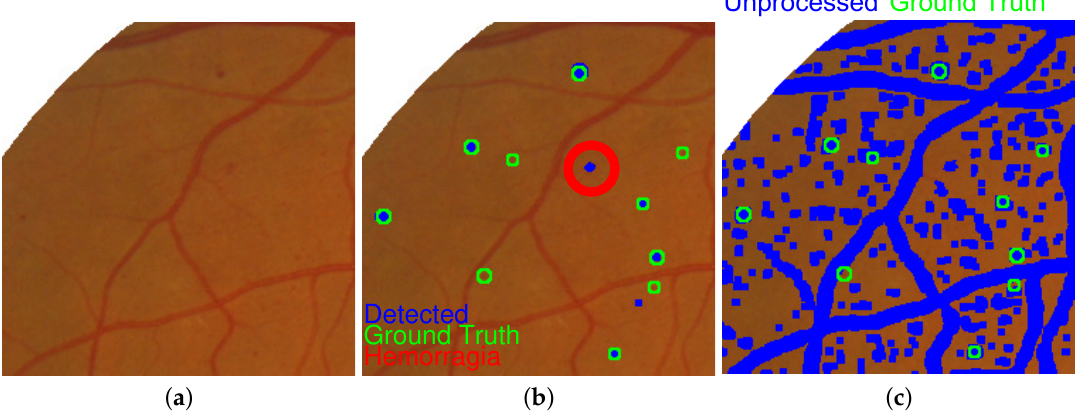
Figure 12. Hemorrhages detection using proposed method: ( a ) original image, ( b ) elements detected as microaneurysms and hemorrhages, and ( c ) final detection obtained by